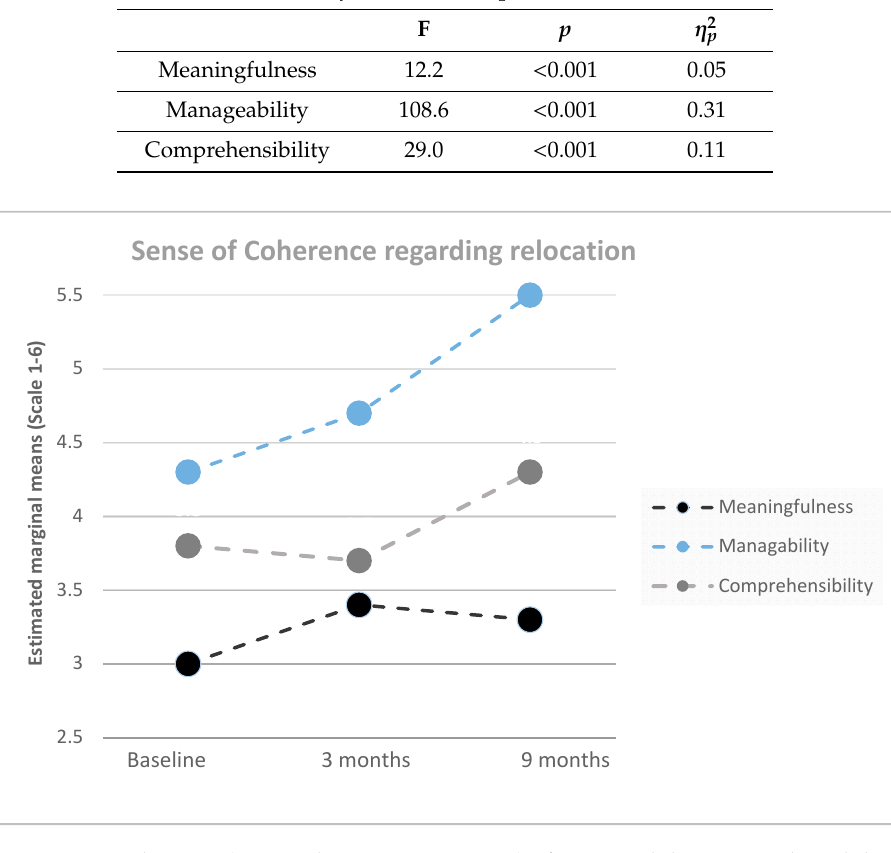
Figure 2. Estimated means (repeated measures ANOVA) of manageability, comprehensibility, and meaningfulness (scale 1–6) regarding the relocation to activity-based workplaces at baseline, 3 months, and 9 months after relocation ( n = 246). Table 1. Repeated measure ANOVA comparing meaningfulness, manageability and comprehensibility between baseline, 3 months, and 9 months after relocation to activity-based workplaces ( n = 246).